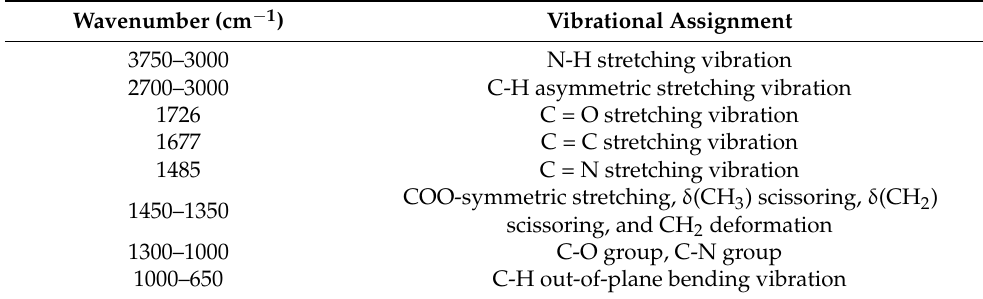
Figure 9. FTIR spectra of original acrylic polyurethane coatings and residue on the laser removal surfaces. Table 4. Peak assignments (cm − 1 ) for FTIR spectra of acrylic polyurethane coatings.